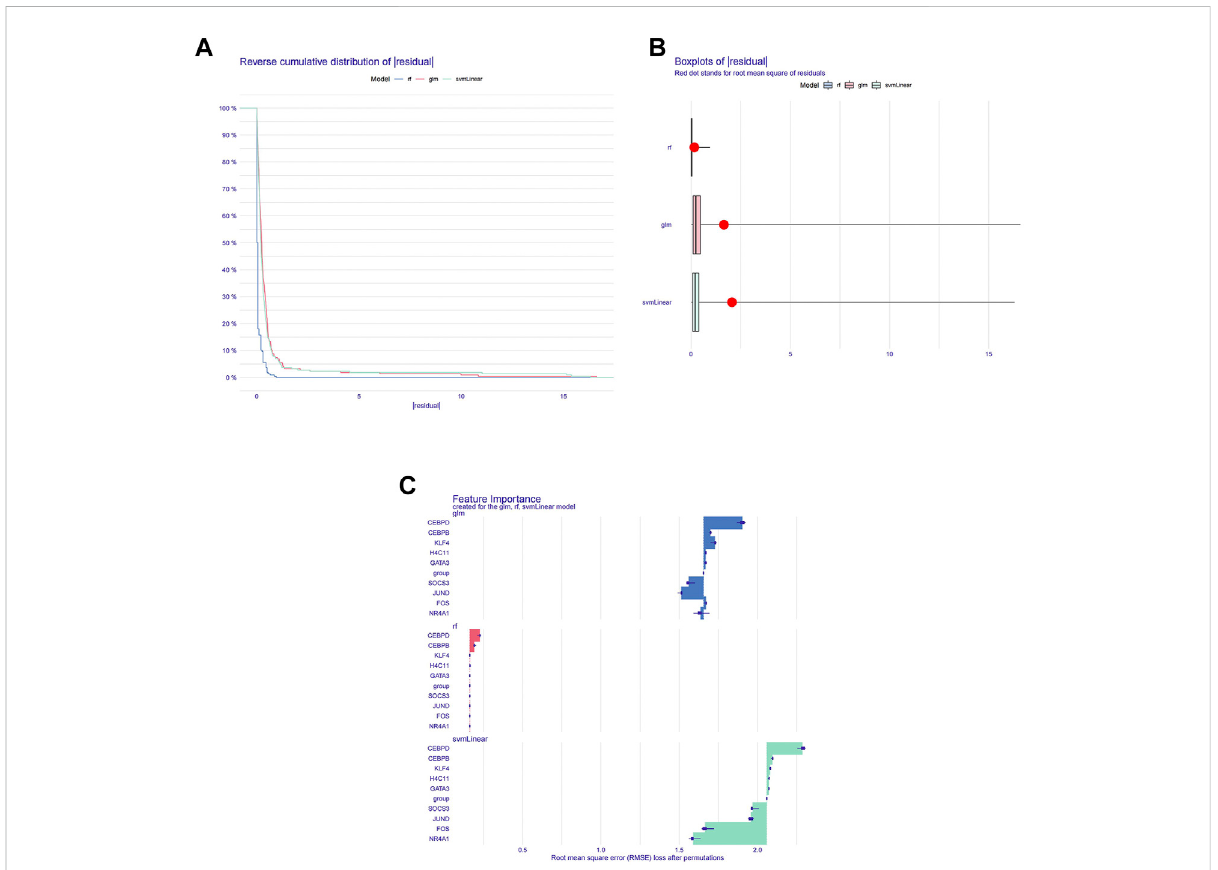
FIGURE 3 Machine learning screening for diagnostic biomarkers. (A) Distribution graphs of sample cumulative residuals. The area under the curve indicates the cumulative residual value of all samples. (B) Boxplot of sample residuals. Red dots indicate the root mean square. (C) Importance of gene variables in the RF, GLM, and SVM